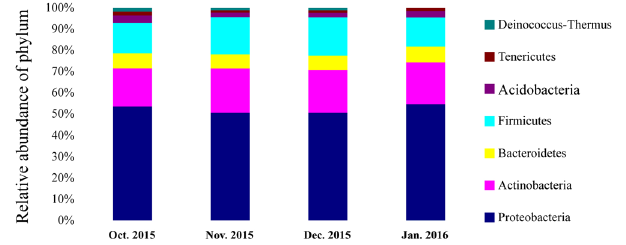
Figure 5. Bacterial community structure variation during overwintering stage at the phylum level of Dendroctonus armandi larvae.